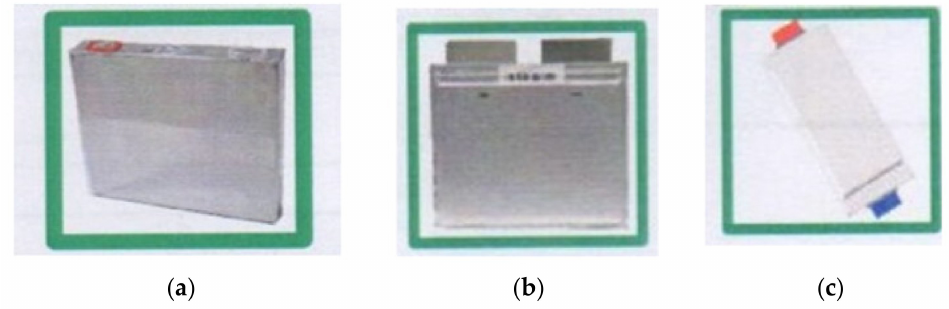
Figure 4. ( a ) LTO (Prismatic) ( b ) NMC-c (Pouch) ( c ) NMC-a (Pouch) and NMC-b